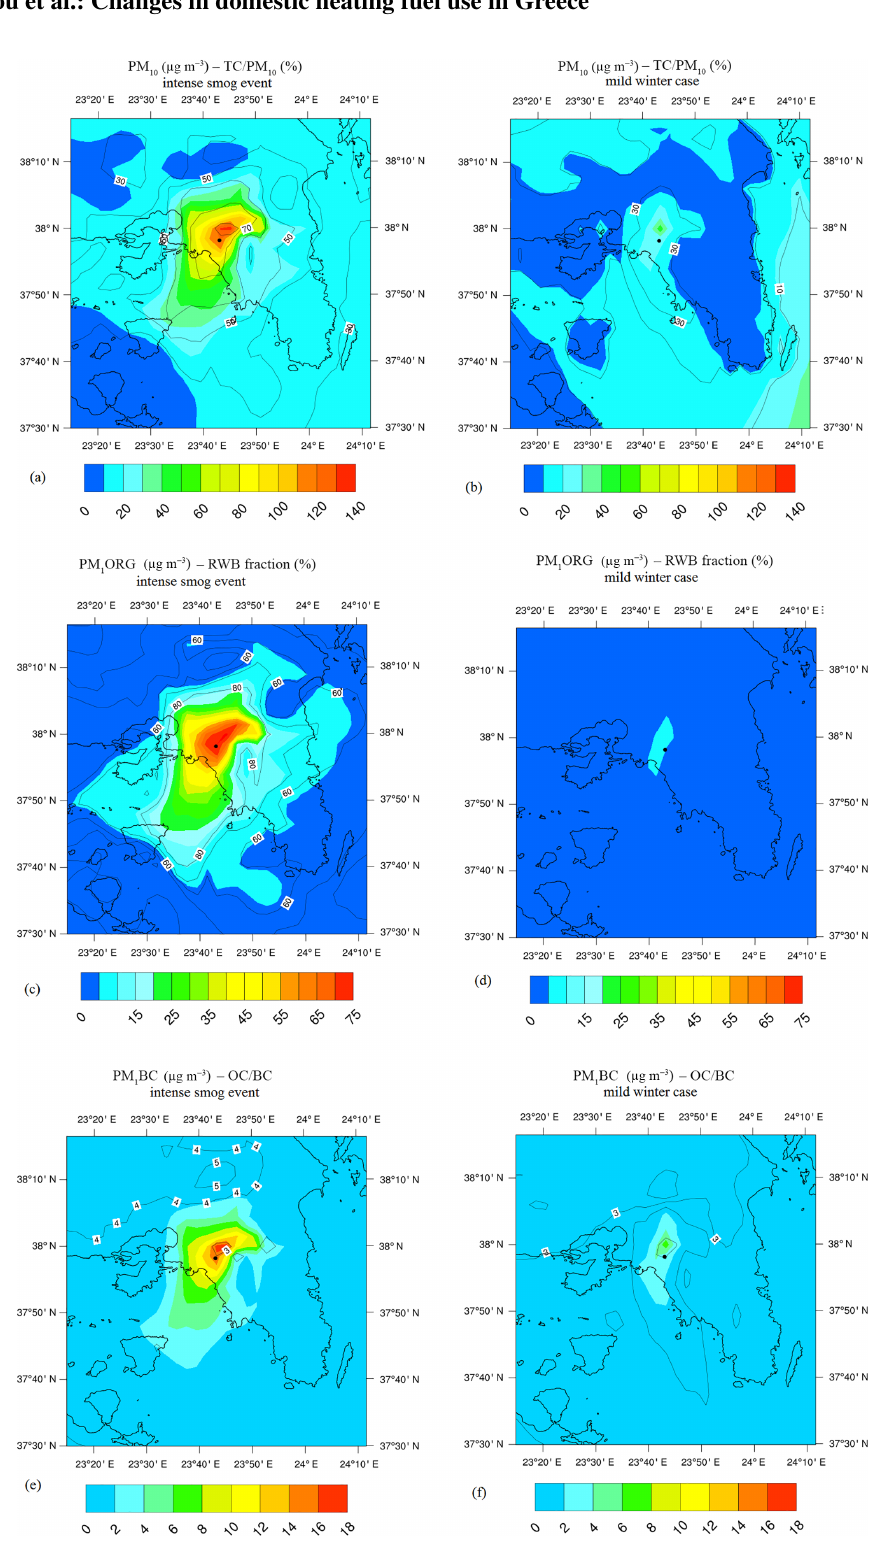
Figure 6. ( a and b ) Mean daily surface concentration (µgm − 3 ) fields of PM 10 . Isolines represent the carbonaceous fraction (OA + BC) of PM 10 (%). ( c and d ) Mean daily surface concentration (µgm − 3 ) fields of PM 1 OA. Isolines represent the RWB fraction of PM 1 OA (%). ( e and f ) Mean daily surface concentration (µgm − 3 ) fields of PM 1 BC. Isolines represent the OC / BC ratio. OC is approximated as OA divided by 1.6, a ratio suggested by Turpin and Lim (2001) for urban areas. All maps cover the extended area of Athens (Thissio is marked with the black dot) and derive from model outputs that correspond to the intense smog event (case 1, left column) and to the mild winter case (case 3, right